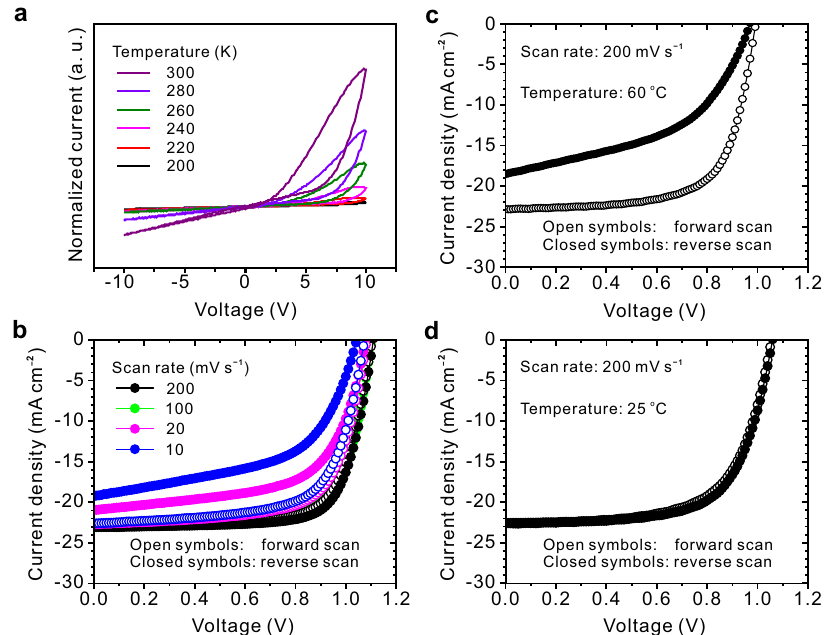
Fig. 1 Indication of ion migration in perovskite fi lms and perovskite solar cells. a Temperature-dependent conductivity measurements in a lateral structured perovskite fi lm. b Scan-rate-dependent current density – voltage curves of perovskite solar cells. c , d Effect of temperature on the hysteresis of perovskite solar cells at a fast scan rate of 200 mV s ‒ 1 . Current density – voltage curves measured at 60 °C ( c ) and after cooling to room temperature ( d ).